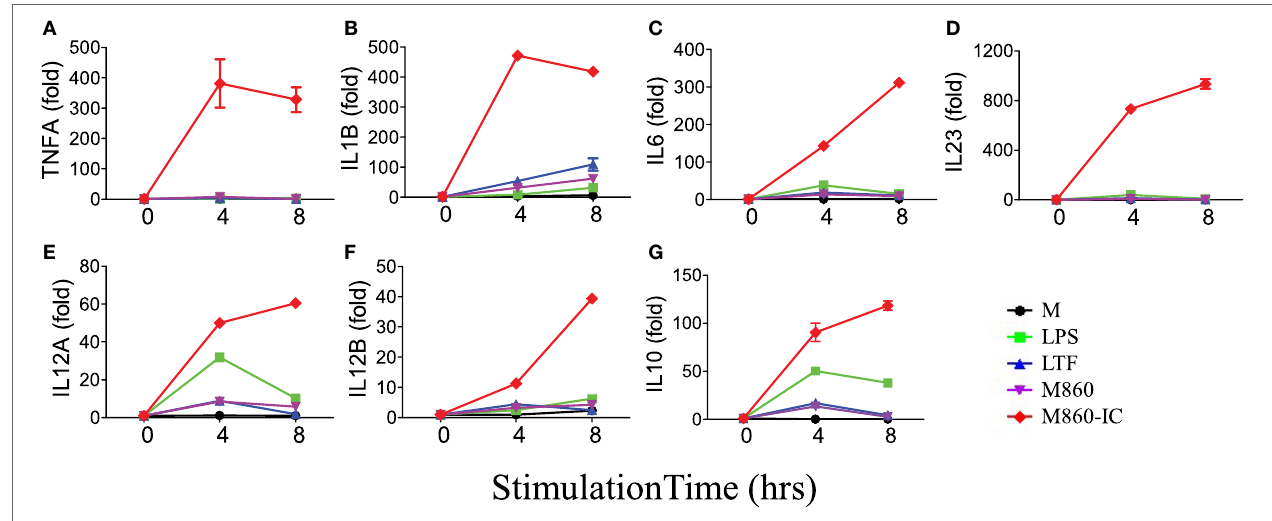
FigUre 2 | M860-IC enhances proinflammatory cytokines transcription in M2. (M-CSF)-M2 macrophages were stimulated with, or without (M), 30 µg/ml human lactoferrin, M860, M860-IC, or 100 ng/ml lipopolysaccharide (LPS) for 4 or 6 h and then analyzed for mRNA expression of (a–g) indicated genes (normalized to GAPDH expression, fold increase compared with unstimulated controls) by quantitative RT-PCR at indicated time points. The results are representative of three experiments with different